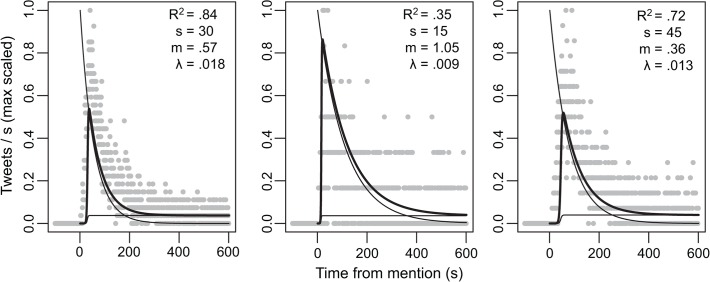
A model of public attention to salient events.The model of public attention reactions to salient events as fit to the three case studies: “Big bird”, “binder” and “bayonet,” from left to right. Note two interlocked timescales: a saliency/novelty followed by the establishment of a meme that sustains a base-level of continued attention. In each panel R
2 indicates the fit of the model, s is the point (in seconds) at which tweet rate is increasing maximally for the “meme,” m reflects the slope of that rate, and λ reflects the decay rate. For more details on the equation cf. methods section.